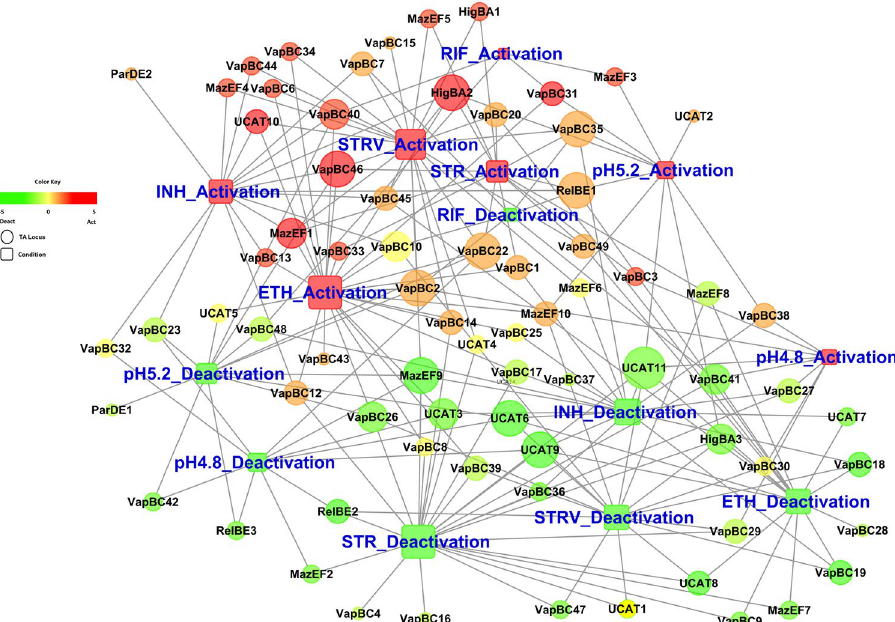
Figure 7. Biological Network of TA loci. Condition-based list of TA loci activated and deactivated was provided to BridgeIsland software. This software identifies the nodes and edges that come together to form a network of connections that could be representative of the TA gene regulation. The nodes (TA loci) are colored based on the activation and deactivation levels with activation being colored in red gradient and deactivation being colored in green gradient and co-expression colored in yellow gradient. The nodes are sized based on their connectivity scores with larger the size indicating a TA is activated/deactivated in as many conditions